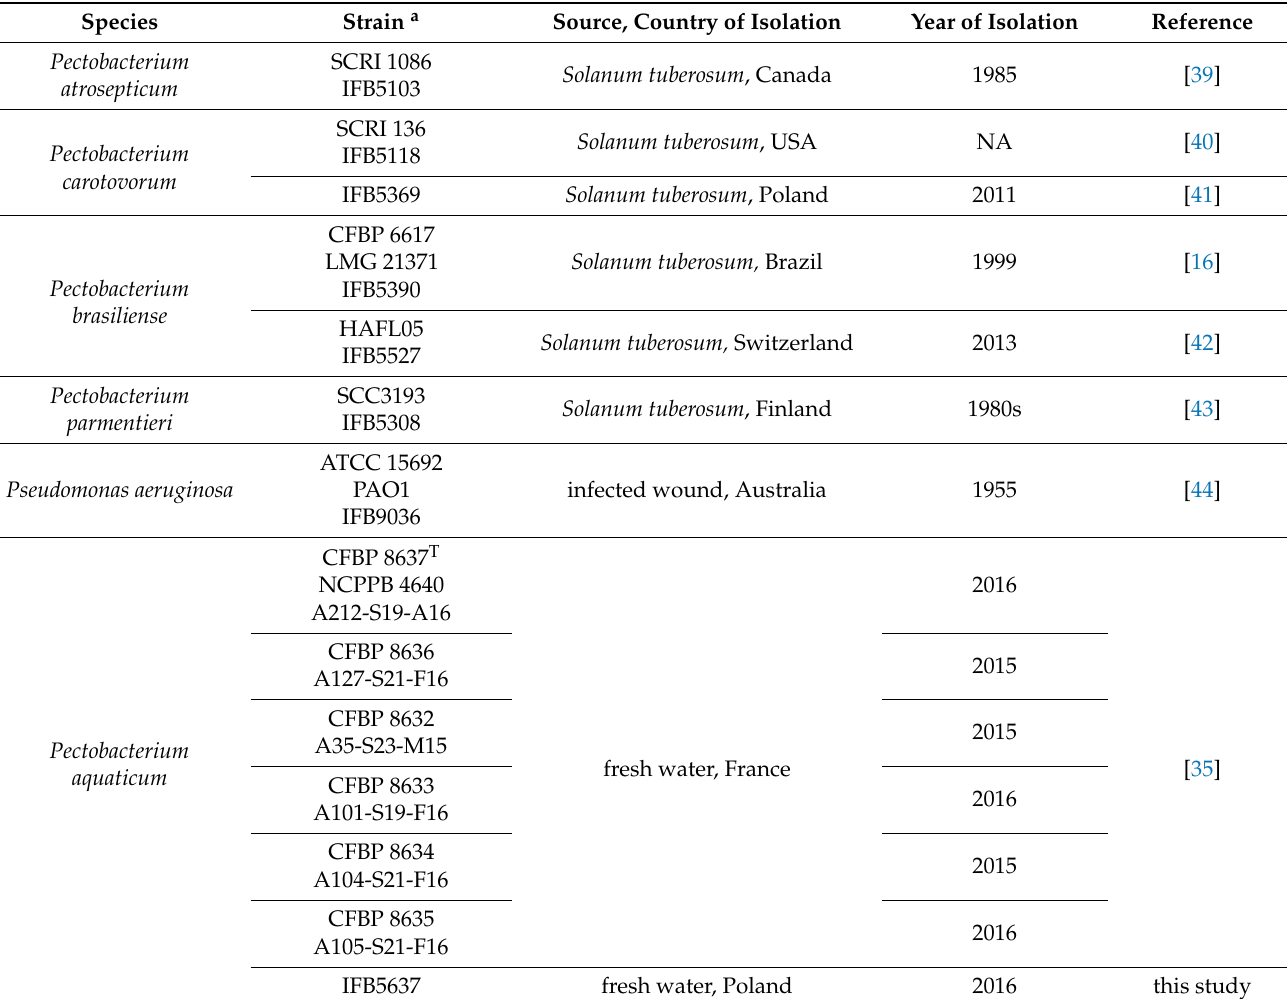
Table 1. Strains of pectinolytic bacteria used in this